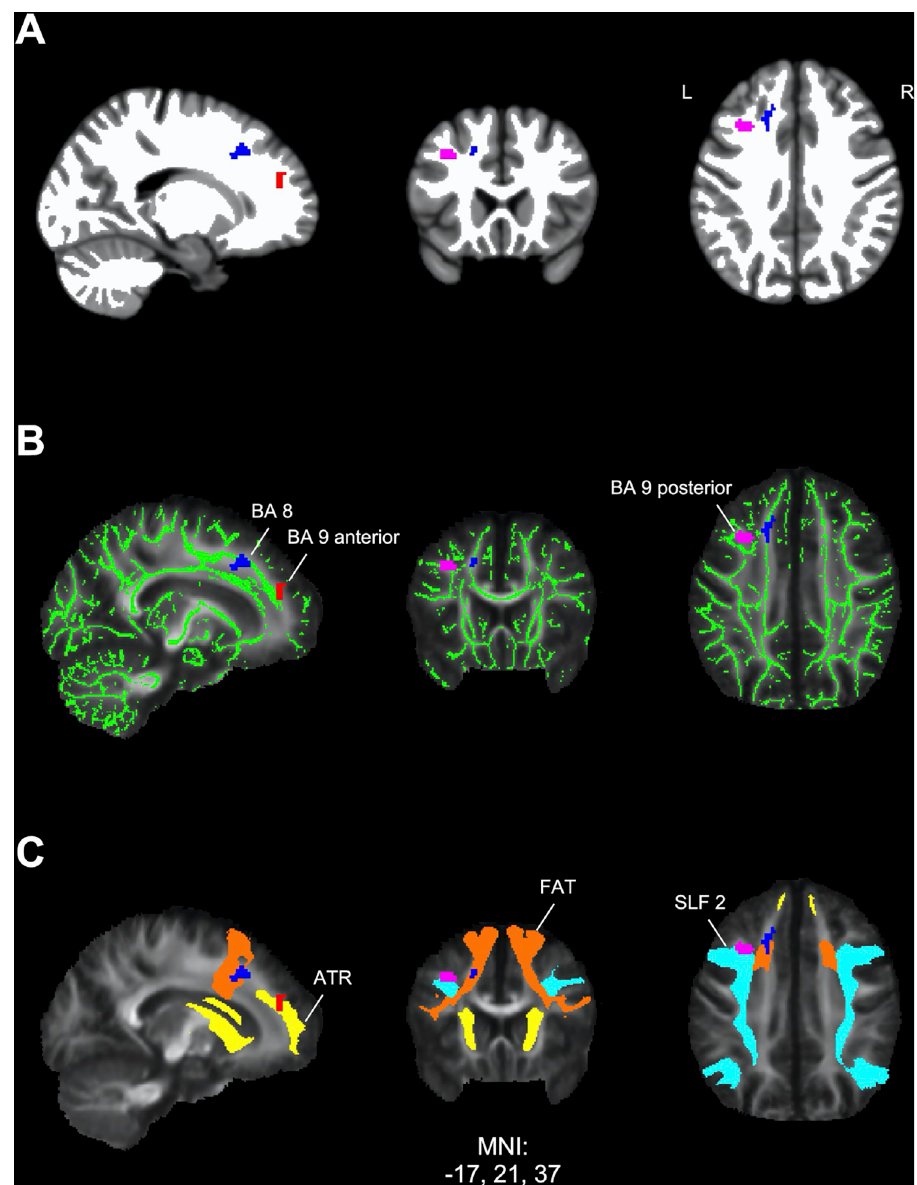
Fig 3. Localization of frontal task-related fMRI activations in white matter. Significant frontal clusters of elevated activation in PTLD participants compared to controls from the contrast values of the forward minus control conditions were transformed into binary regions of interest (ROIs) labeled by their Brodmann area location. Blue: Brodmann area 8 (BA 8) ROI, red: Anterior Brodmann area 9 (BA 9 anterior) ROI, pink: Posterior Brodmann area 9 (BA 9 posterior) ROI. Labeled ROIs were used to compute the percent overlap with each of the following measures. (A) White matter mask (white) derived from a study-specific T1 template using tissue class segmentation analysis. The BA 8 ROI showed 80.06% overlap, the BA 9 anterior ROI showed 89.39% overlap, and the BA 9 posterior ROI showed 99.73% overlap with white matter. (B) Mean fractional anisotropy (FA) and white matter skeleton (green) maps derived using diffusion tensor imaging (DTI) analysis showing overlap with fMRI ROIs. The BA 8 ROI showed 25.00% overlap, the BA 9 anterior ROI showed 22.35% overlap, and the BA 9 posterior ROI showed 24.46% overlap with skeletonized white matter. For reference, the white matter skeleton accounts for 34.47% of the overall white matter mask from the tissue class segmentation. (C) Mean FA map overlaid with three long range white matter pathways obtained from DTI. The BA 8 ROI showed 41.57% overlap with the frontal aslant tract (FAT; orange), the BA 9 anterior ROI showed 49.62% overlap with anterior thalamic radiation (ATR; yellow), and the BA 9 posterior ROI showed 57.61% overlap with the superior longitudinal fasciculus 2 (SLF 2; cyan). L = left, R = right